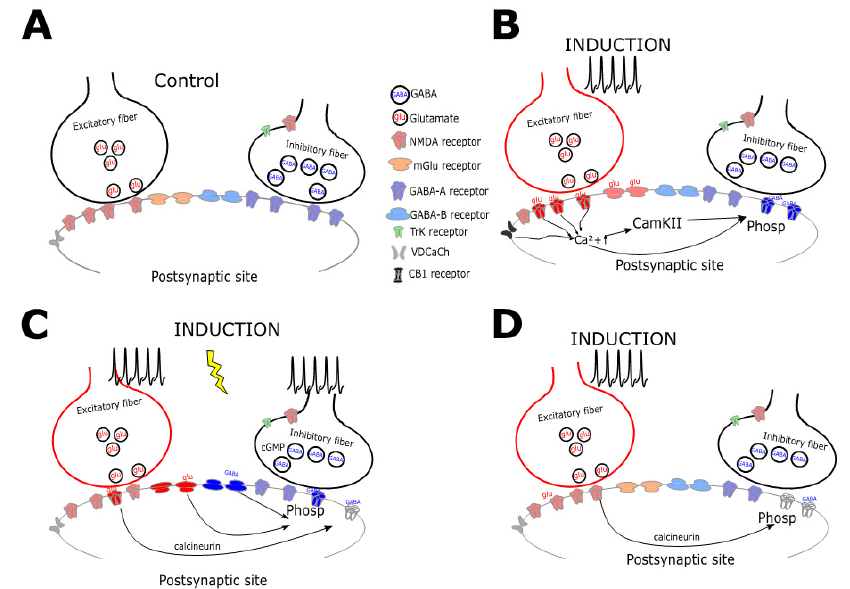
Figure 3. Schematic diagram collecting the mechanisms underlying postsynaptic plasticity. A.